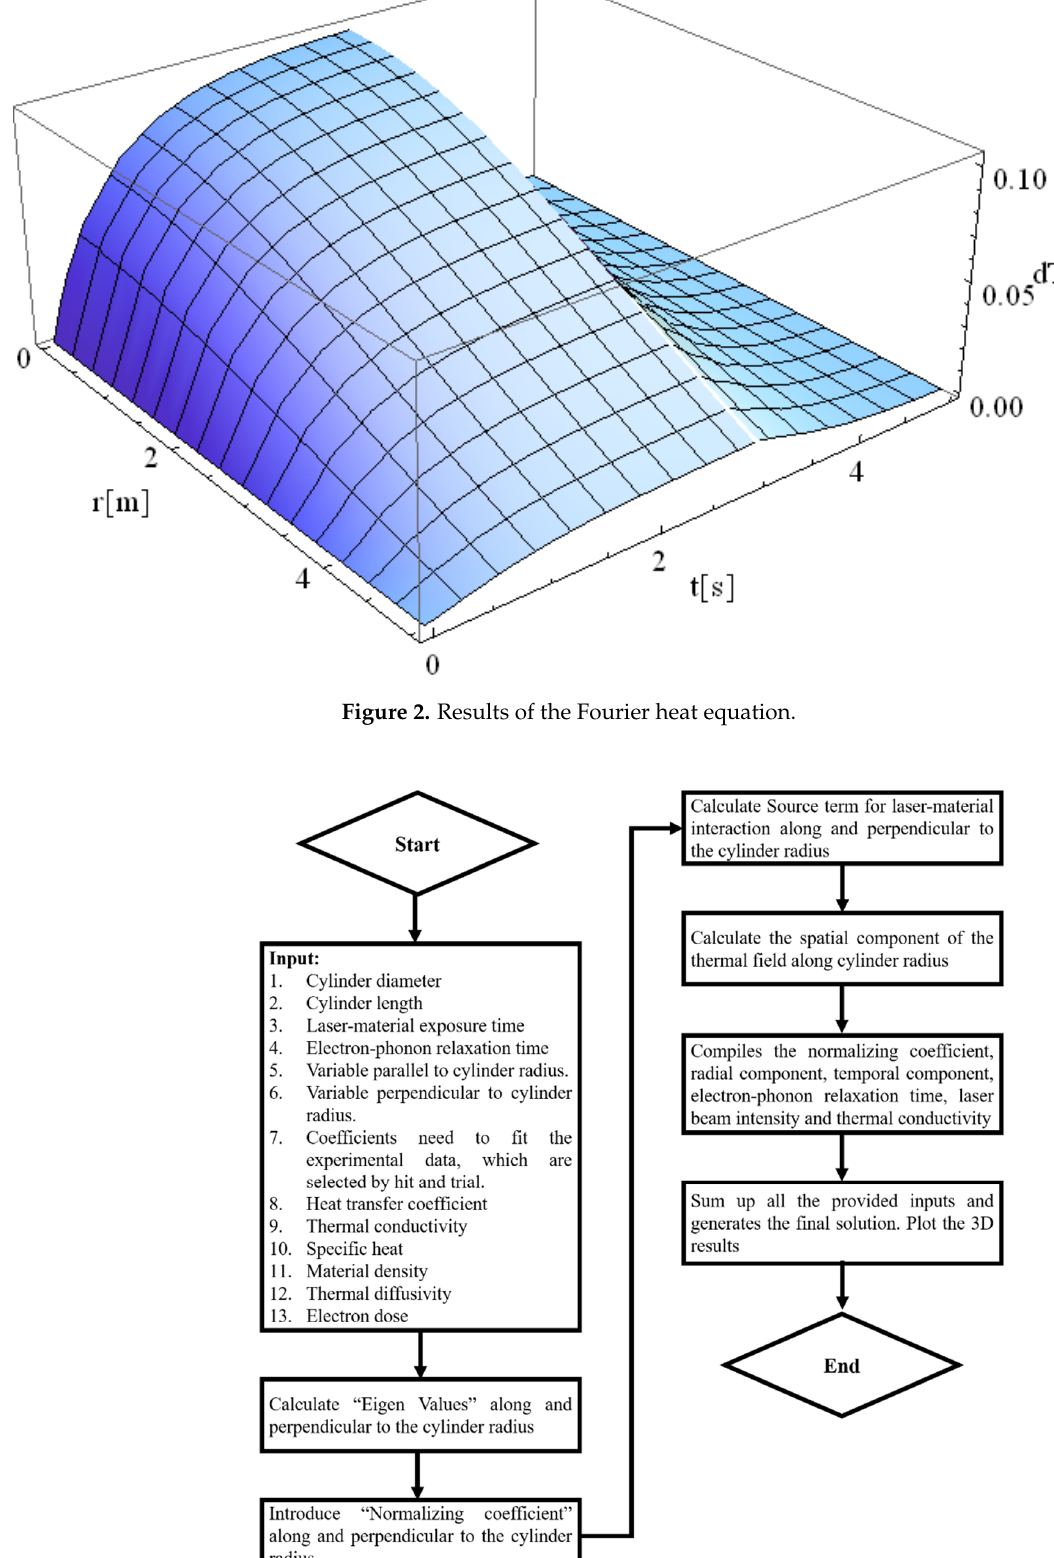
Figure 1. Flow chart to conduct simulation using Fourier heat equation.